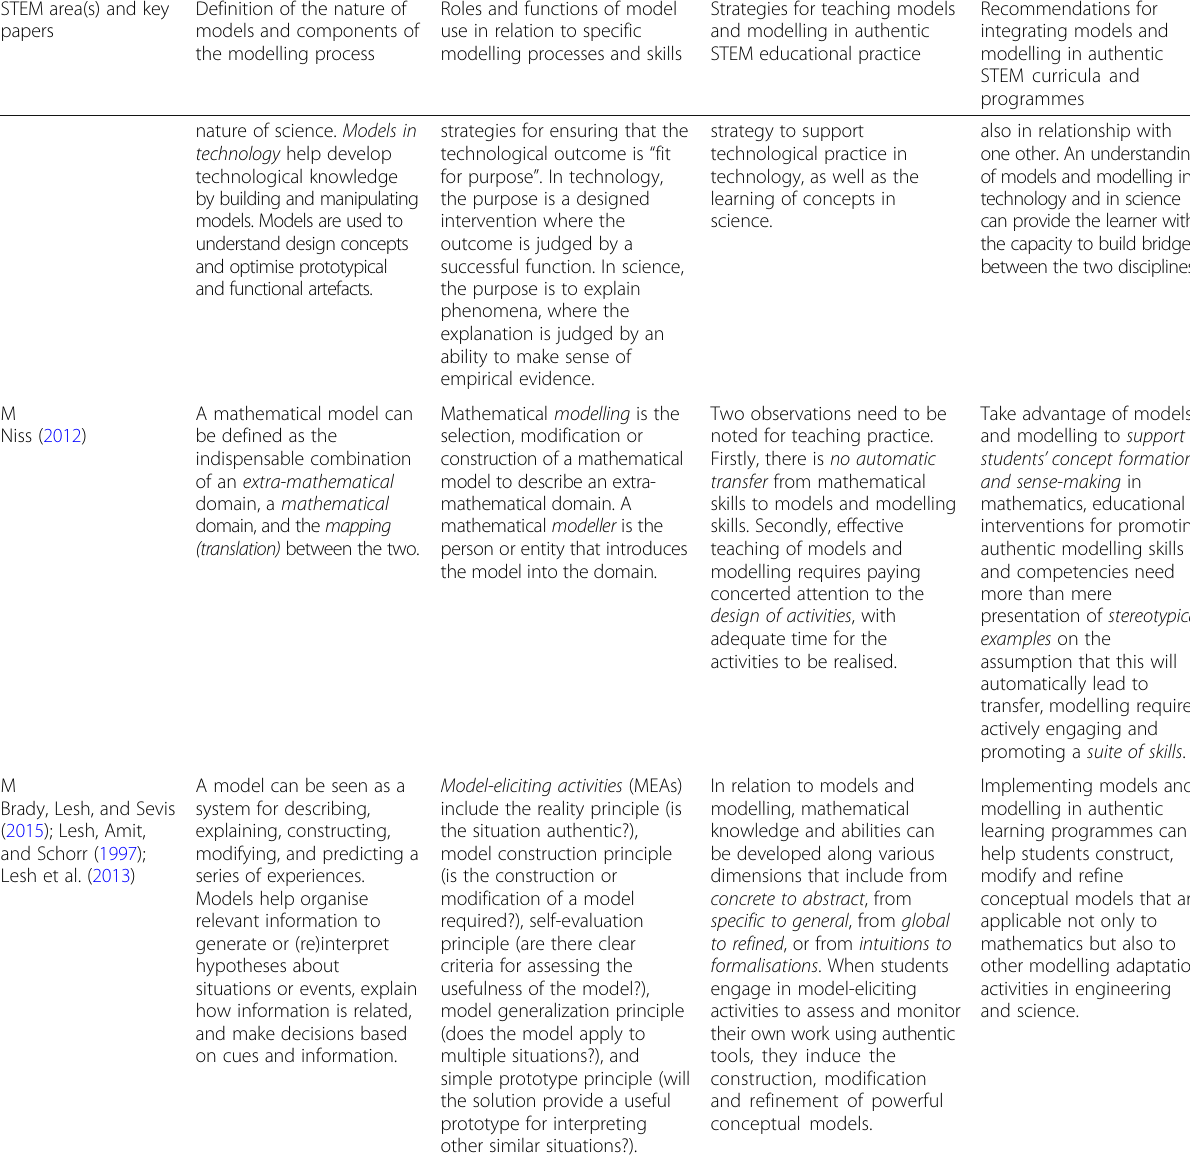
Table 1 Roles, functions, strategies and recommendations for using models and modelling in pursuit of authentic STEM education and literacy